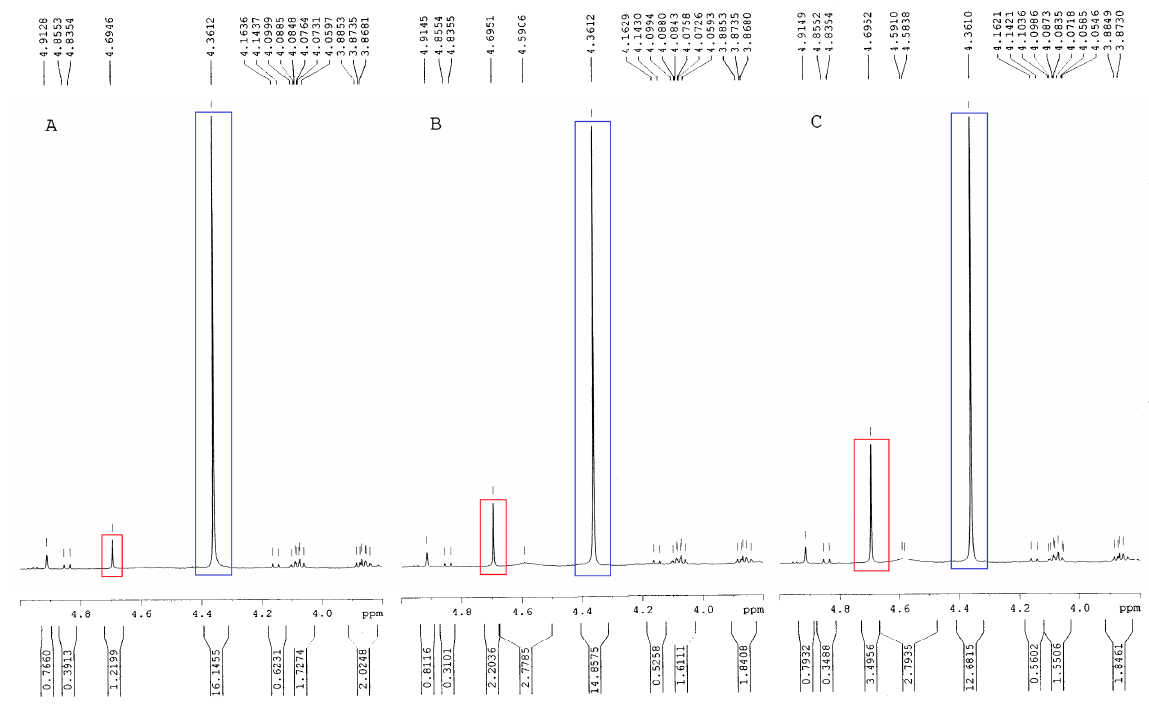
Table 3. Characteristic values of chemical shifts for individual compounds and areas under the peaks after the specified irradiation time assigned from 1 H NMR spectra.